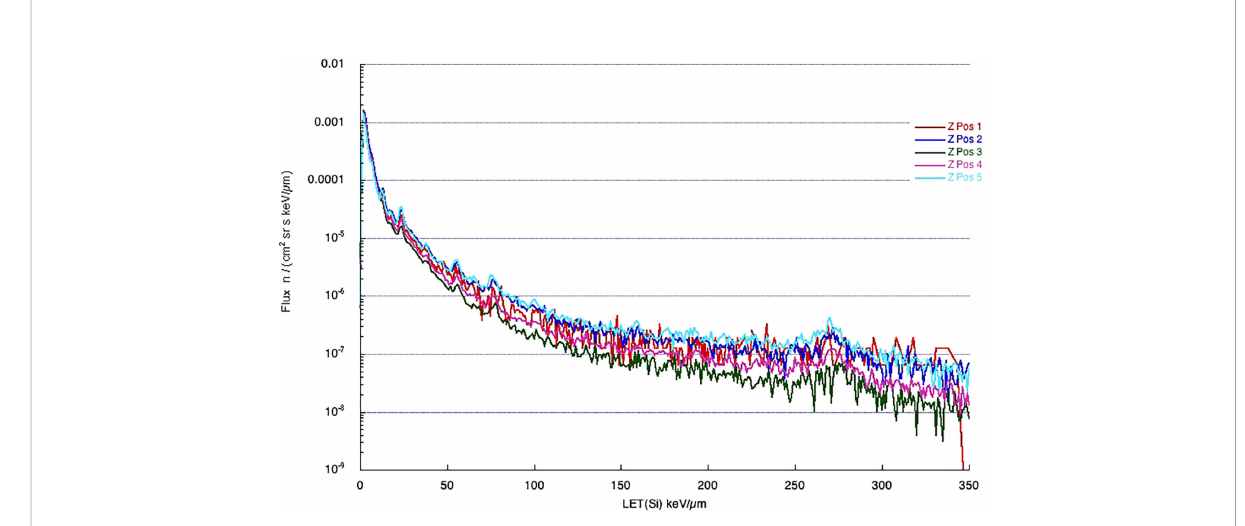
FIGURE 2 Spectra measured by ALTEA in 2012 in fi ve positions in the ISS (four in the USLab, one, position 5, in Columbus), in the Z direction of the ISS coordinates (from Earth to Zenith). [Reproduced from Narici et al., 2015,